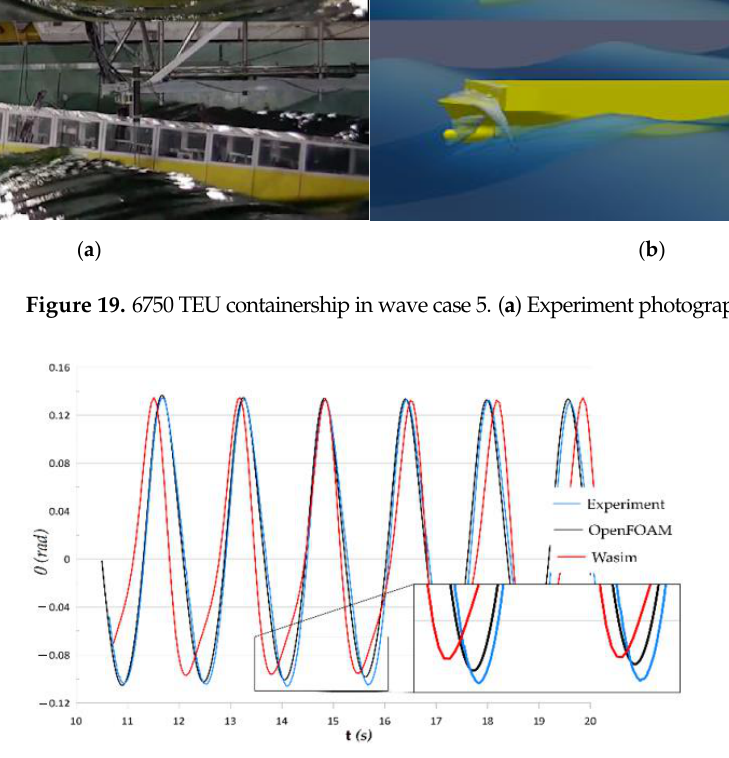
Figure 20. Time signals of pitch motion from experiment and numerics for H = 0.46 m for the 6750 TEU containership.